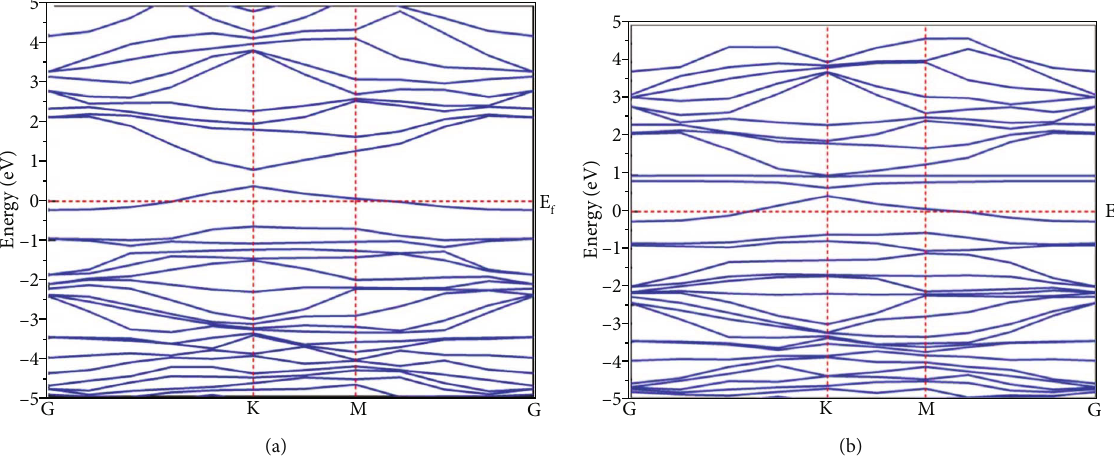
Figure 11: The band structure of Al-Graphene and N